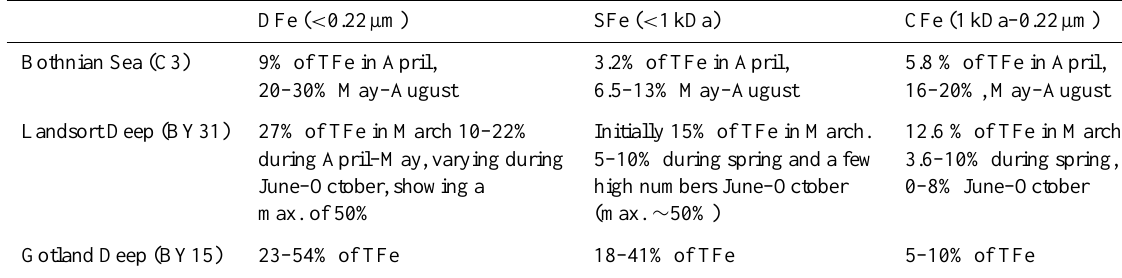
Table 2. Different fractions of Fe expressed as percentage of total Fe